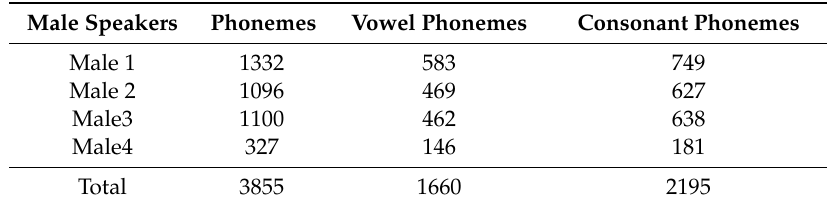
Table 2. Dataset from male